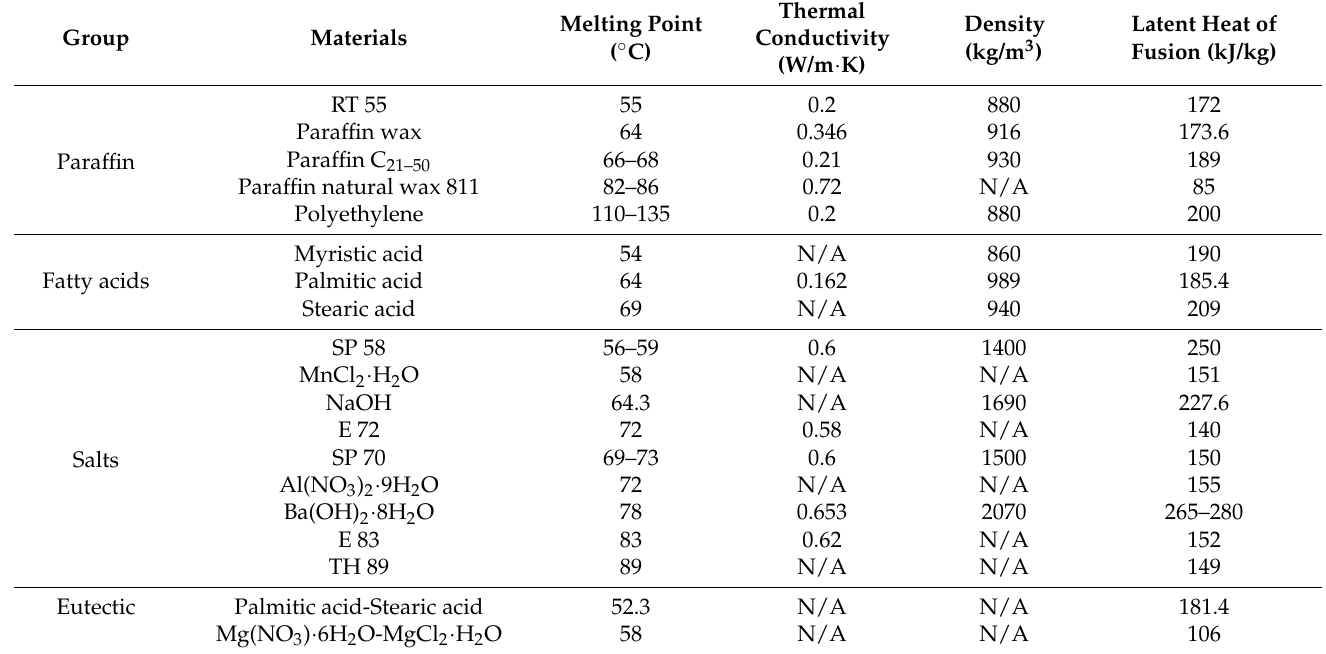
Table 4. Commonly used materials for latent heat storage